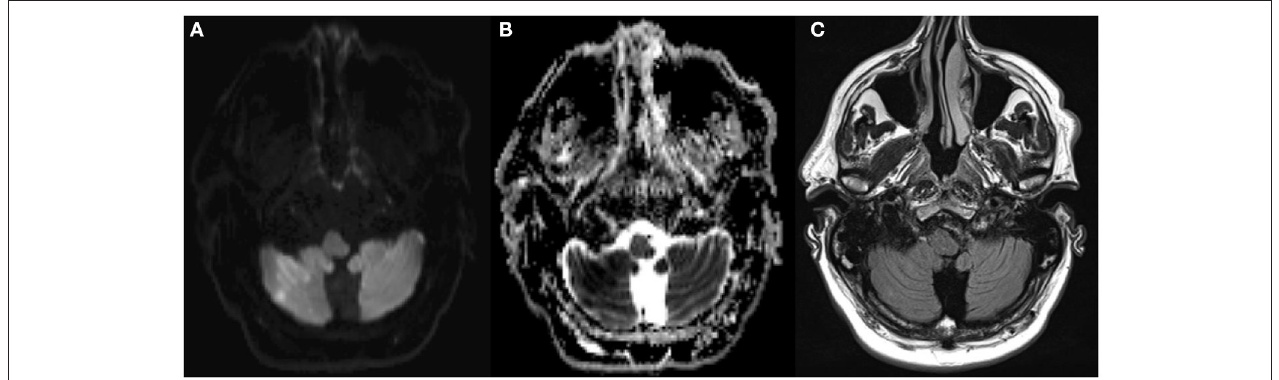
FIGURE 3 | Fifty-five year old man with acute onset of mild dysathria and ataxia of the trunk, unable to walk (NIHSS 1). MRI showed an acute infarction [DWI positive (A) , ADC negative (B) , FLAIR negative (C) ] in the territory of the occluded right posterior inferior cerebellar artery. The patient was treated with rtPA 3h and 46min after stroke